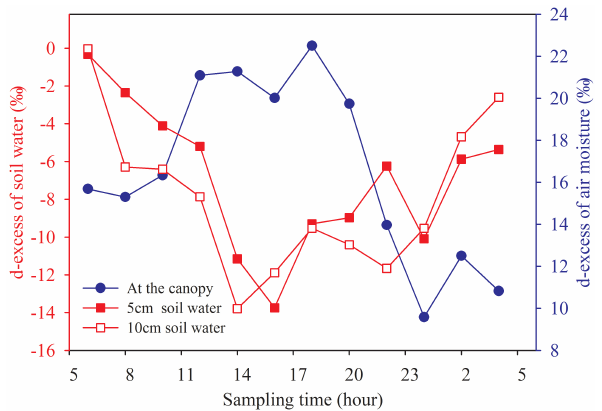
Figure 10. Comparison of soil water and air moisture d-excess val- ues during the sunny days after the 4h rain event on 2 August 2009 at